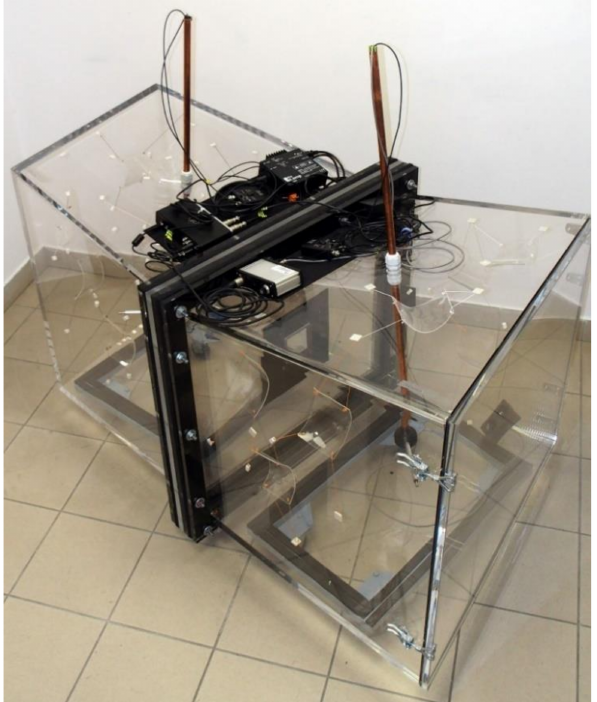
Figure 1. Coupled reverberation rooms in the 1:8 scale with equipment.